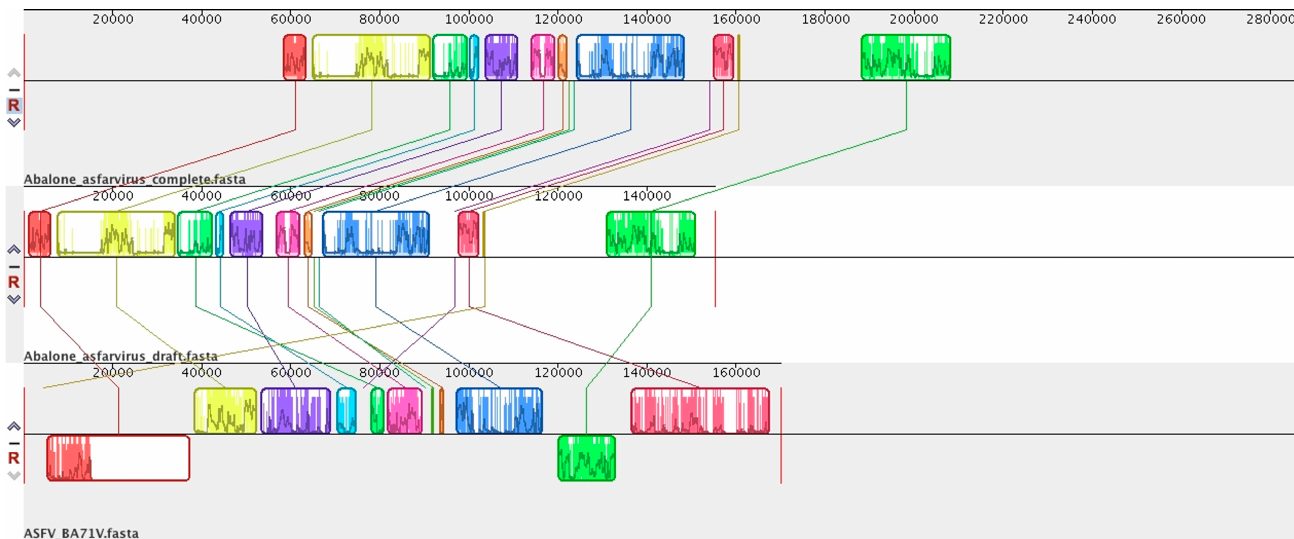
Figure 1. Genome synteny between Abalone Asfarvirus genome and the ASFV-BA71V genome. Schematic genome alignment obtained using the Mauve software [102]. The analysis was performed using the genome of Abalone Asfarvirus (LC637659.1), draft genome and ASFV strain BA71V (NC_001659.2). The blocks illustrated above the x axis are in the positive strand (forward sense), while blocks below the x axis are in the negative strand (reverse sense). The names of each virus are indicated below the sequence. The connected lines represent the relatively similar blocks between the